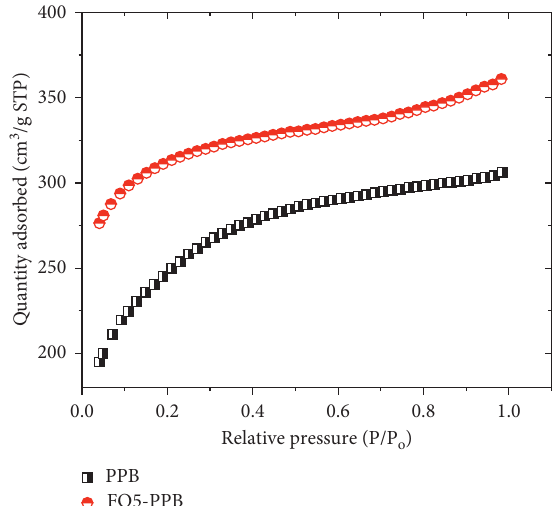
Figure 2: Adsorption isotherms of N